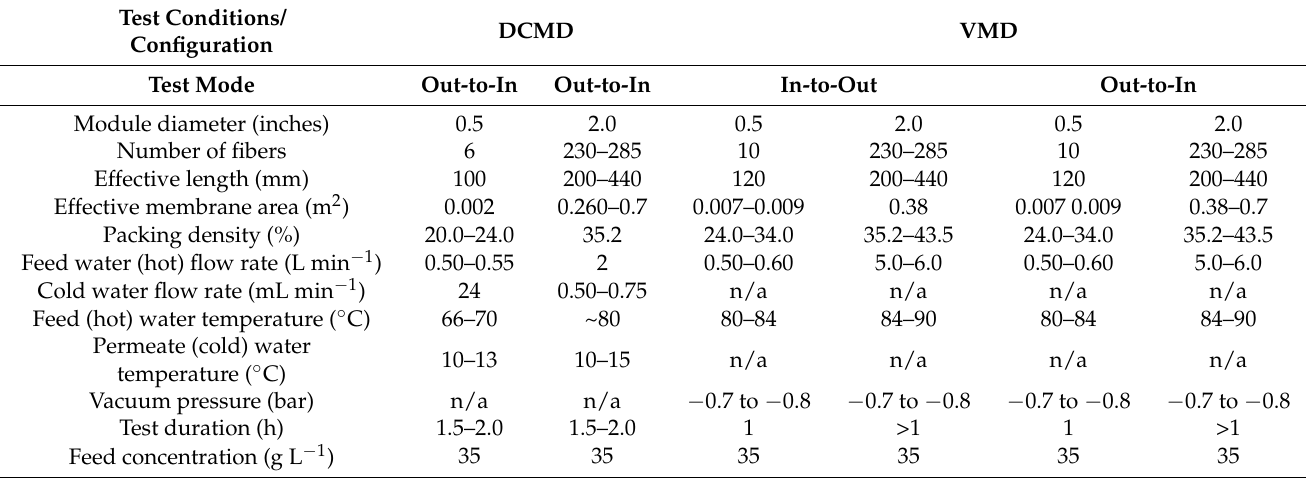
Table 2. Testing conditions of DCMD and VMD for 0.5-inch and 2-inch